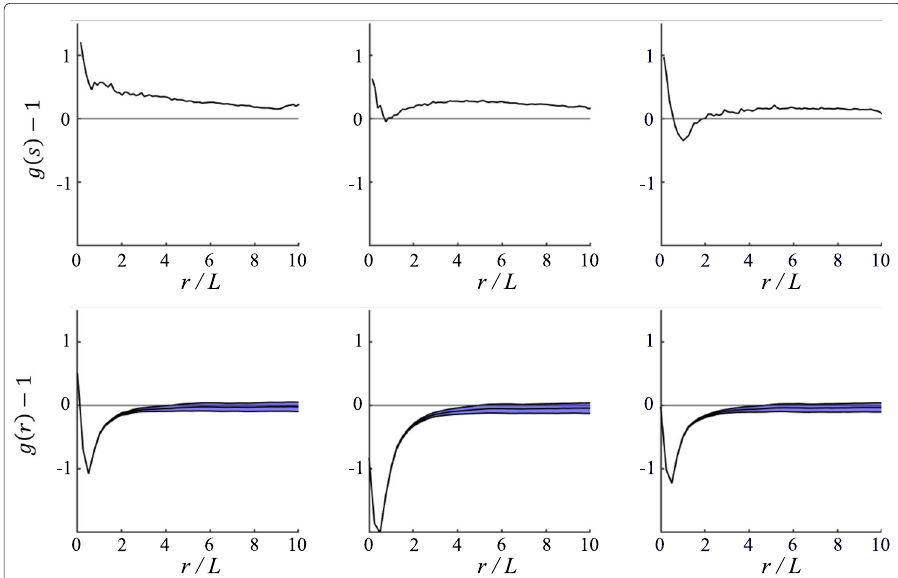
Fig. 7 Radial correlation functions. Shown with ± 1 standard error region. The correlations shown were calculated with a convolution length of 64 nm to examine large separation distances. The in-plane standard errors are too small to display on these axes. The in-plane radial correlation does not converge to an uncorrelated state ( g − 1 = 0) in the spatial region examined. However, the spherical radial correlation function decays quickly to zero, with the error bars including zero by r = 5